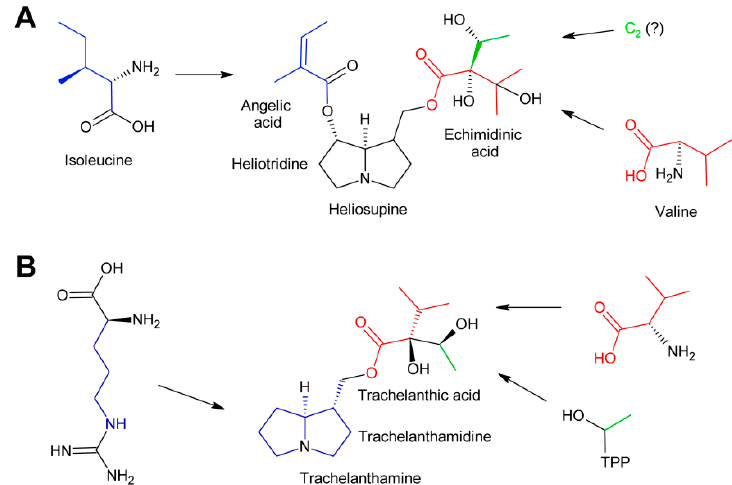
Figure 12. Biosynthesis of C 7 necic acids. ( A ) Echimidinic acid present in heliosupine is derived from L -valine (red) and a C 2 unit of unknown origin (green). Angelic acid esterifying the 7-hydroxy group of (-)-heliotridine is derived from L -isoleucine (blue) as shown in Figure 11. ( B ) Trachelanthic acid is also derived from L -valine (red) and a C 2 unit (green) that is likely derived from hydroxyethyl thiamine pyrophosphate. Adapted from References [70,103].